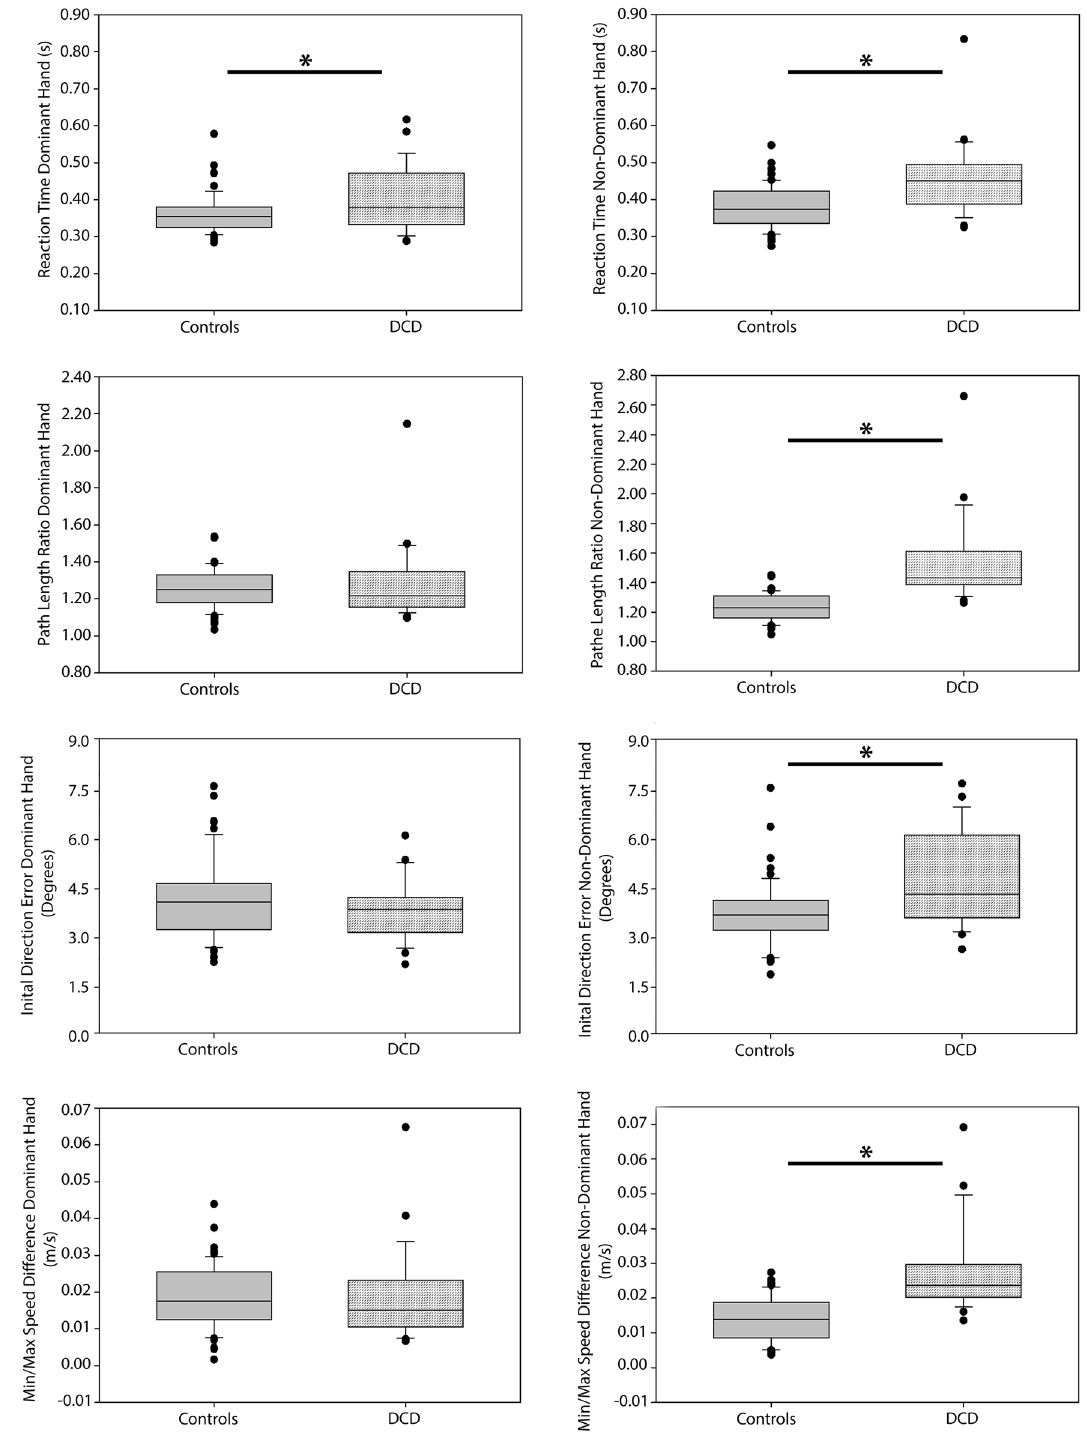
Figure 5. Group differences in performance on the visually guided reaching task. Box plots are shown for both the dominant and non-dominant limbs. *p < MABC-II Aiming and Catching subscale scores were negatively correlated with non-dominant limb reaction time; specifically, higher scores on this MABC-II subtest, which indicated better performance, were significantly correlated with faster (i.e., lower) reactions times on the visually guided reaching task. MABC-II Balance sub- scale scores were negatively associated with dominant limb min/max speed difference and non-dominant limb initial direction angle; such that lower scores on the MABC-II, indicating poorer performance, were associated